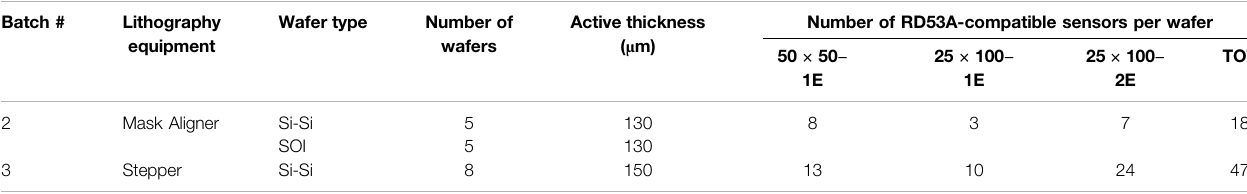
TABLE 1 | Overview of FBK 3D small-pitch pixel batches 2 and 3 aimed at ATLAS and CMS upgrades at HL-LHC. Batch